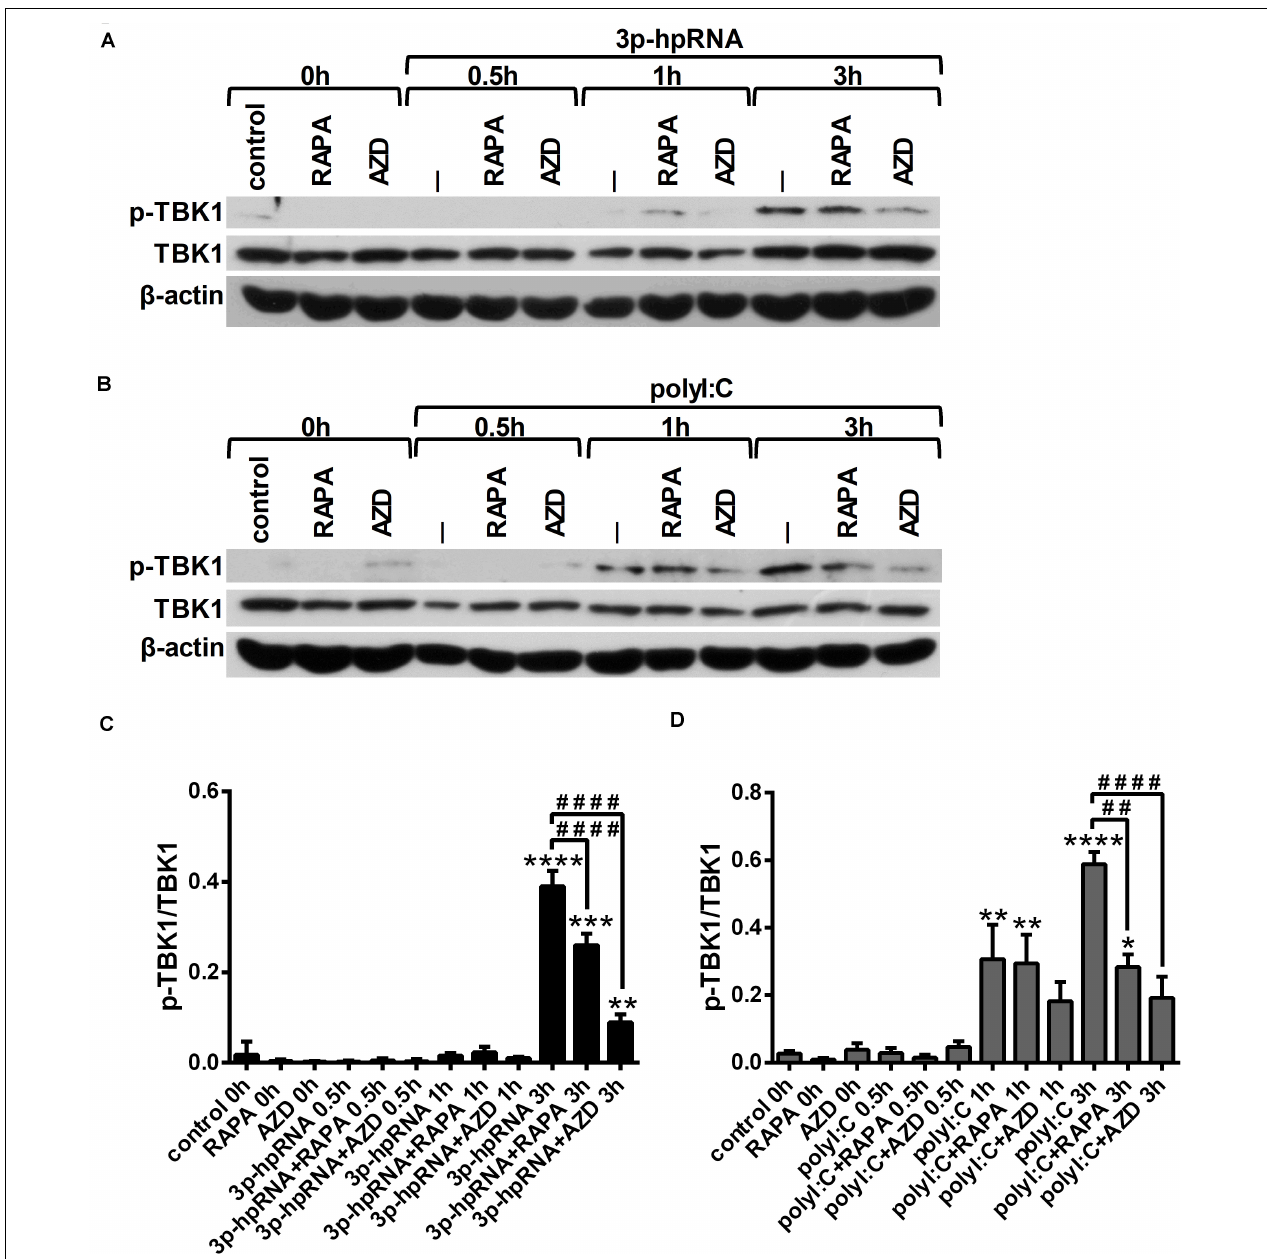
FIGURE 4 | RLR stimulation enhances TBK1 activity in moDCs that is decreased by rapamycin and AZD8055 pre-treatment. Immature moDCs were pre-treated with vehicle control, 100 nM rapamycin (RAPA) or 100 nM AZD8055 (AZD) for 2 h then stimulated with 3p-hpRNA (0.5 µ g/ml) (A,C) or polyI:C (1 µ g/ml) (B,D) for different time periods. Kinetics of TBK1 phosphorylation were determined by western blotting. (A,B) Representative blots are shown. (C,D) Bar graphs represent the mean ± SD of at least 3 independent experiments. * p < 0.05, ** p < 0.01, *** p < 0.01, **** p < 0.0001 vs. control; ## p < 0.01, #### p <